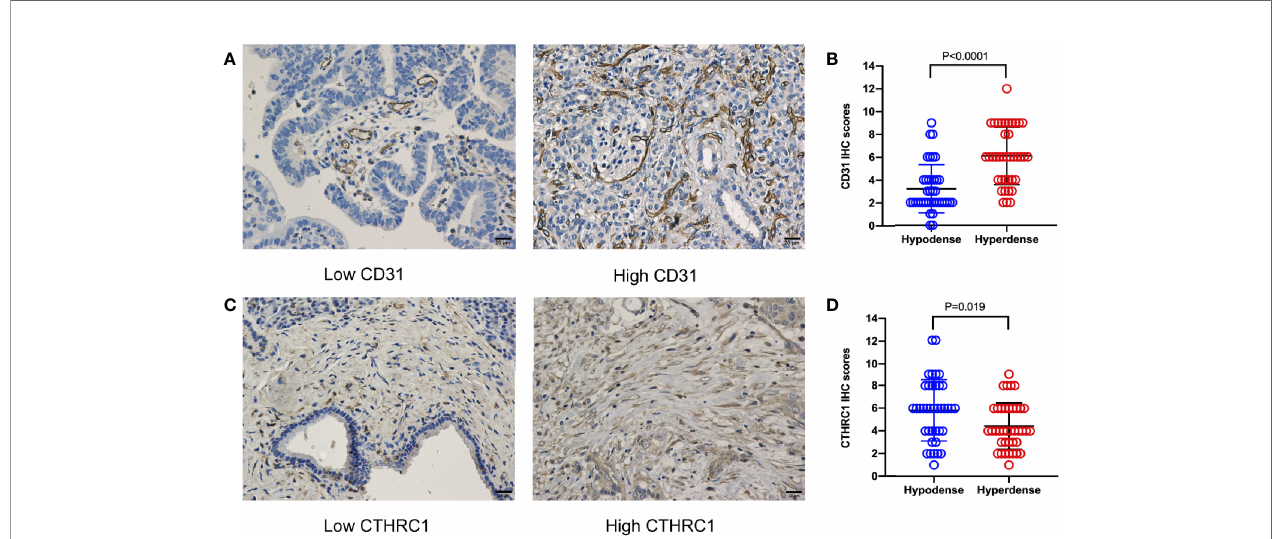
FIGURE 4 | CD31 and CTHRC1 IHC staining in PDAC. (A) Representative images of PDAC samples according to CD31 expression (scale bar: 20 m m). (B) Statistical results of the CD31 expression comparison between the hypo- and hyperdense groups using the Mann-Whitney U test. (C) Representative images of PDAC samples according to CTHRC1 expression (scale bar: 20 m m). (D) Statistical results of the CTHRC1 expression comparison between the hypo- and hyperdense groups using the Mann-Whitney U test.